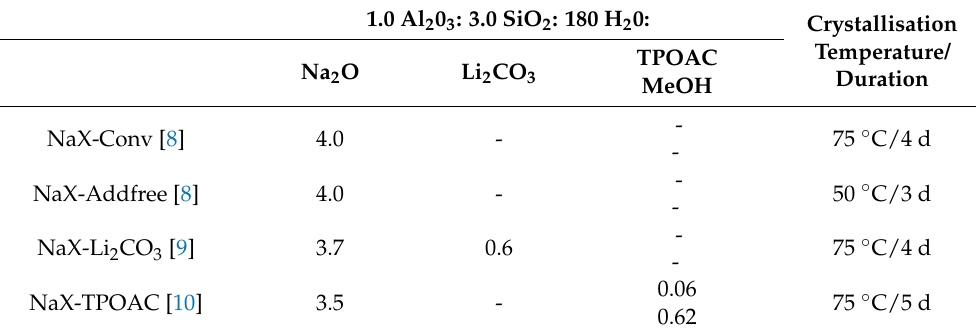
Table 4. Molar synthesis gel compositions and crystallisation parameters of all four synthesis routes with NaX-Conv giving conventional FAU morphology and NaX-add-free, NaX-Li 2 CO 3 , and NaX- TPOAC giving layer-like crystal morphology